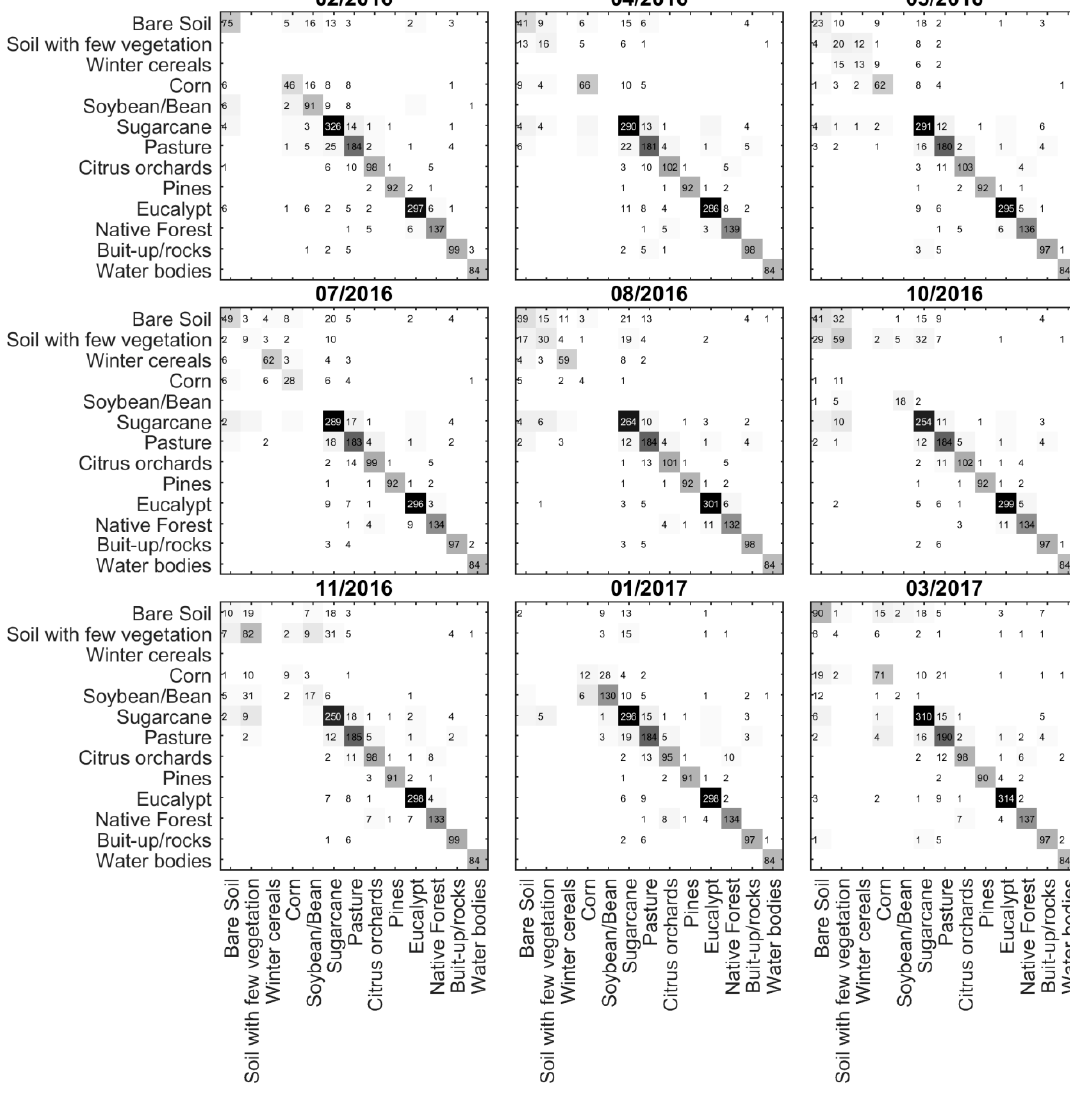
Figure 5. Confusion matrices after a cross validation, for each date at classification level 4. Rows are the reference, while columns are the predicted class. The numbers associated with the levels of gray represent the number of observations.